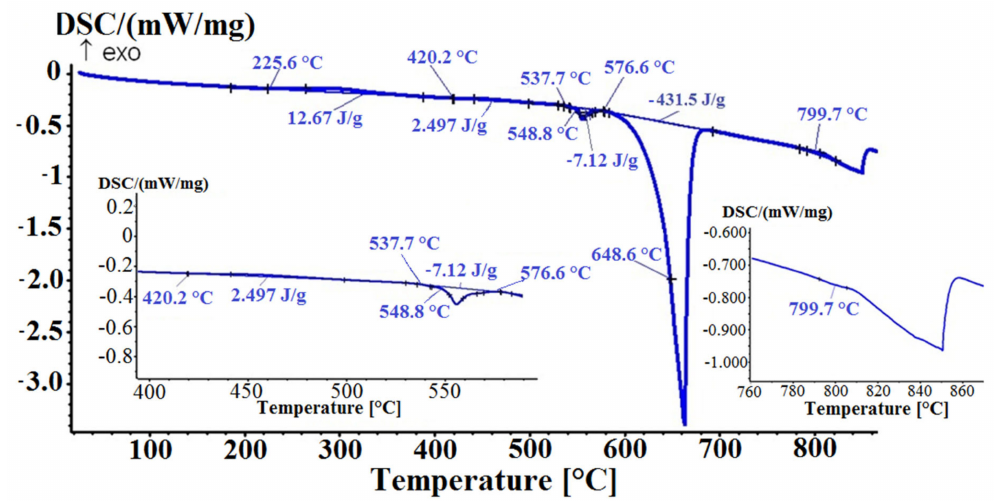
Figure 10. Detailed thermodynamic analysis (DSC) heating curve (sample 1M60, heating rate 10 ◦